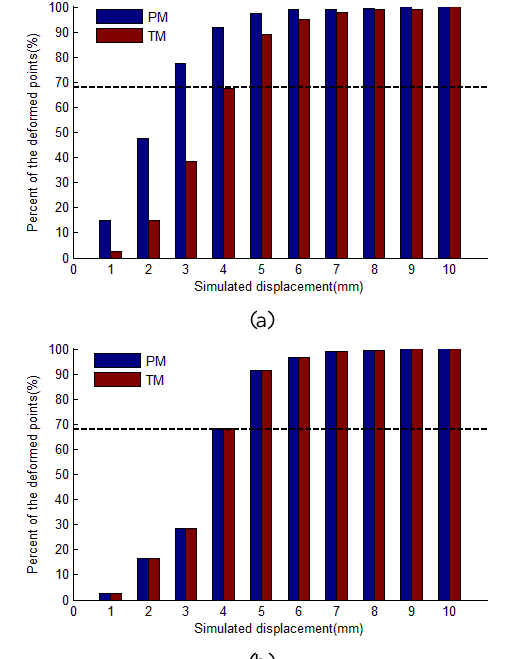
Figure 7. Results of the PDOP of each data point cloud with the varying sampling interval: (a) sampling interval=2mm; (b)